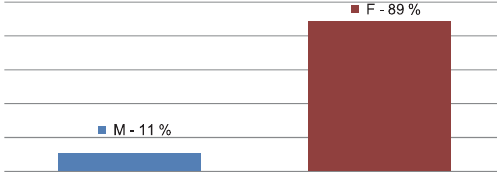
FIGURE 1. Distribution of respondents by gender